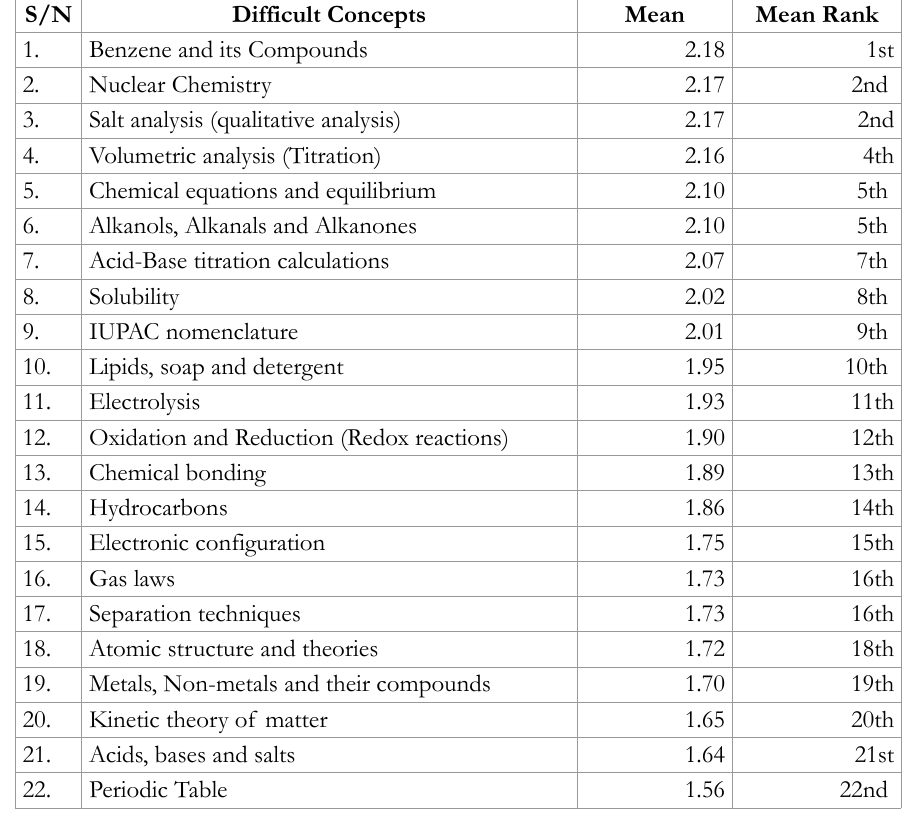
Table 1. Ranking of difficult concepts in senior secondary chemistry (Oladejo, Okebukola, Olateju et al.,